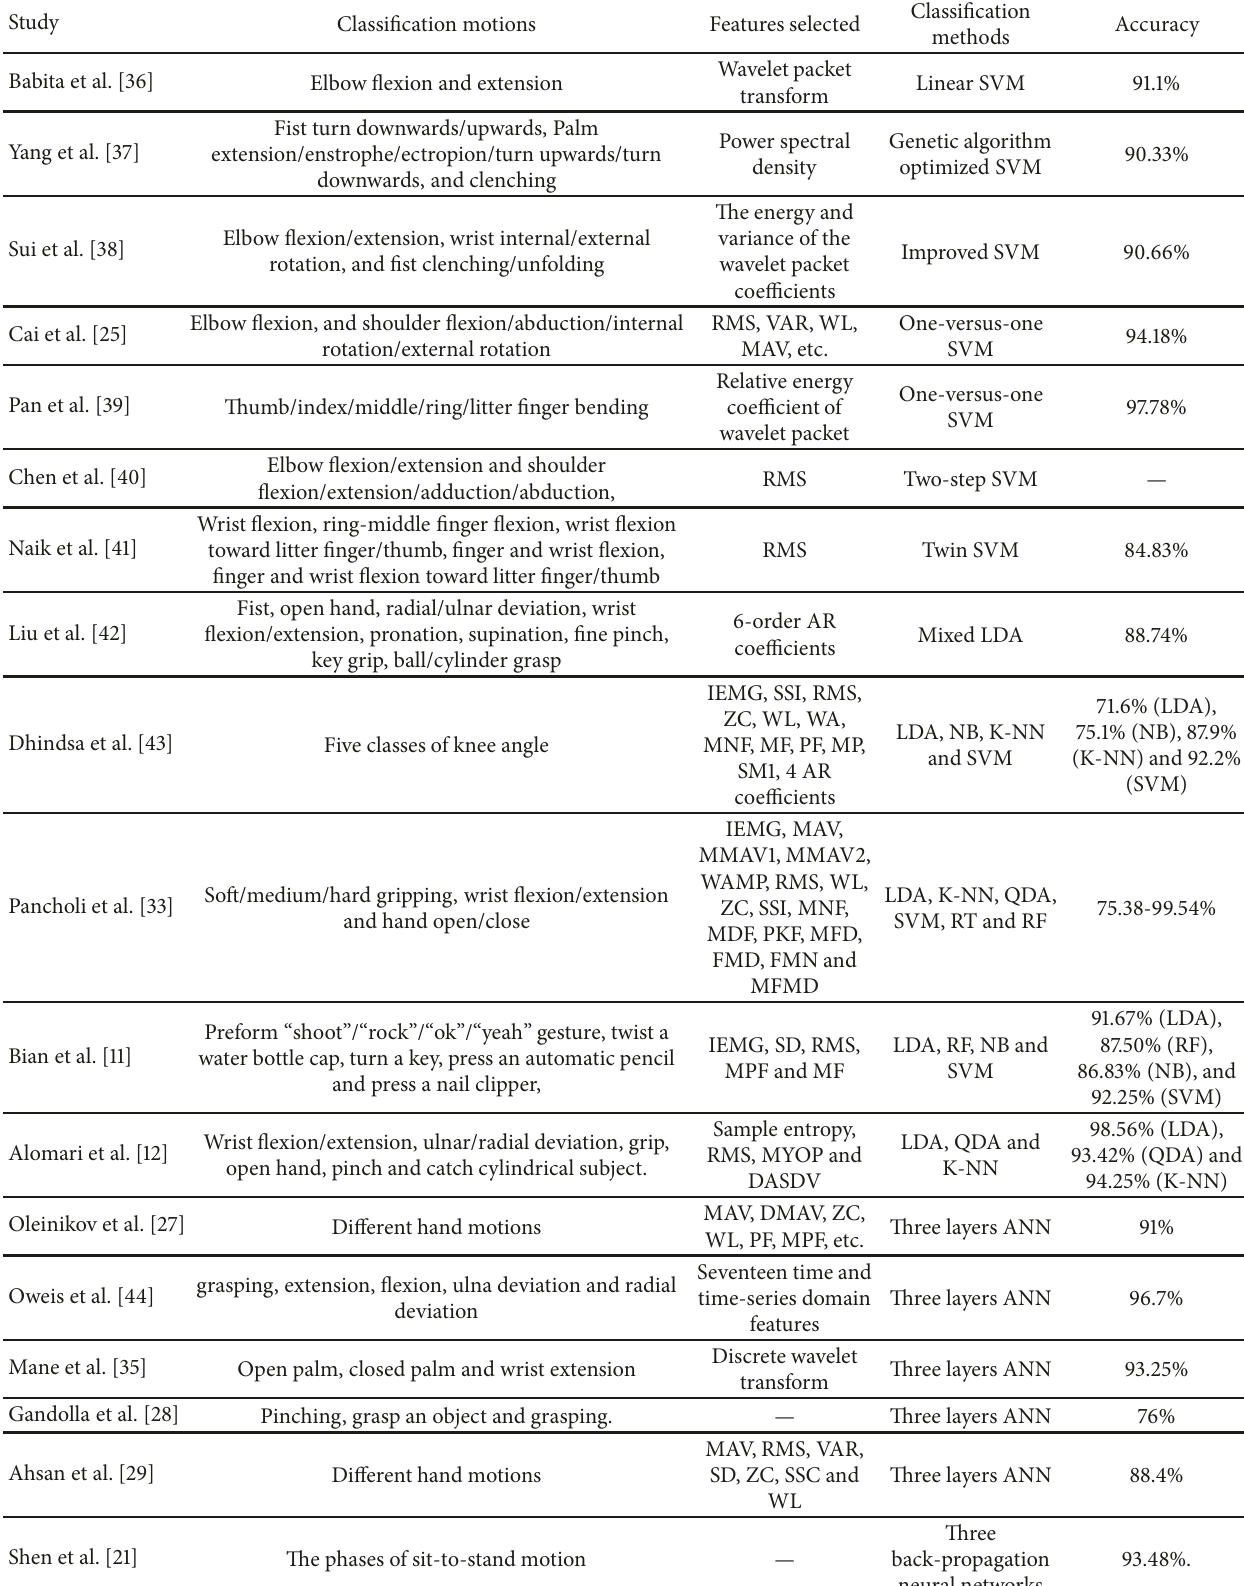
Table 1: Results from most recent studies for discrete-motion